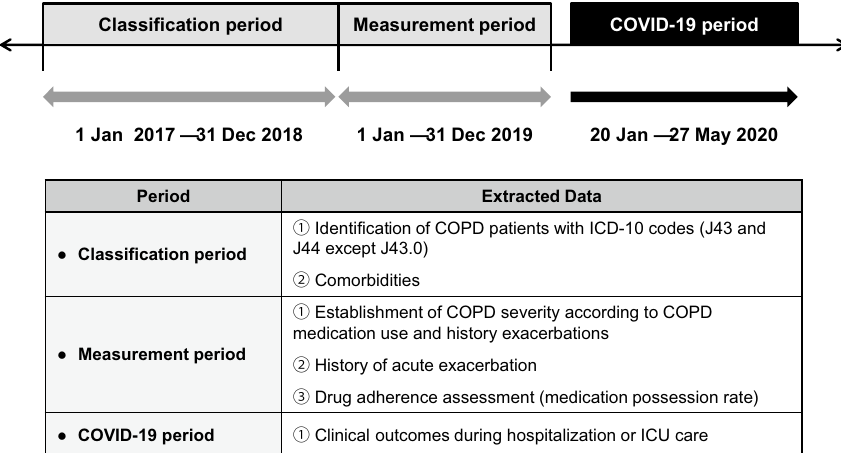
Figure 1. Study scheme. Information on the study population was collected for three different periods: enrollment, measurement, and COVID-19. COPD patients were identified, and the baseline characteristics of patients were assessed during the enrollment period. COPD severity, the number of acute exacerbations, and the medication possession ratio were evaluated during the measurement period. COVID-related clinical outcomes were evaluated during the COVID-19 period. COVID-19, coronavirus disease 2019; COPD, chronic obstructive pulmonary disease; ICD-10, 10th revision of the International Statistical Classification of Diseases and Related Health Problems; ICU, intensive care